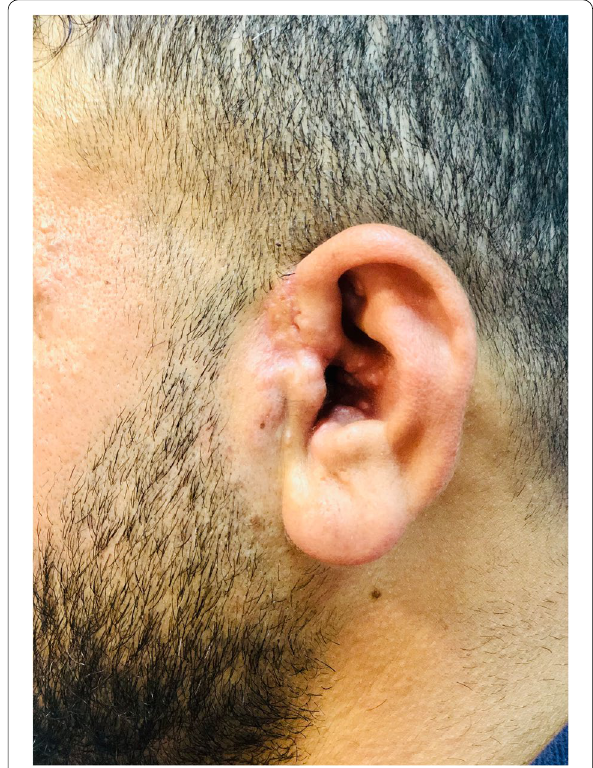
Fig. 4 View of the external auditory canal six months after the